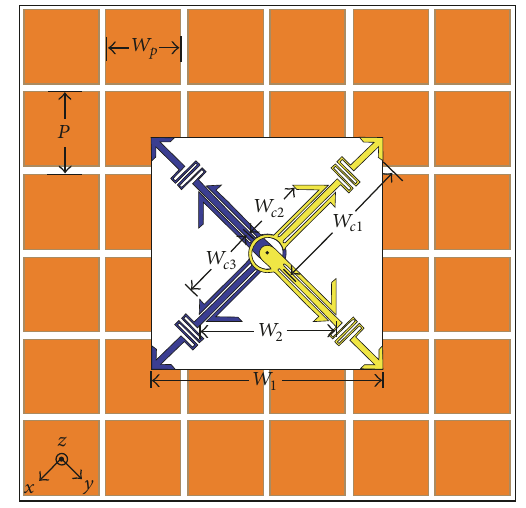
Figure 4: The illustration of the compact circular polarized crossed dipole antenna with high impedance surface (HIS) on the back of the antenna